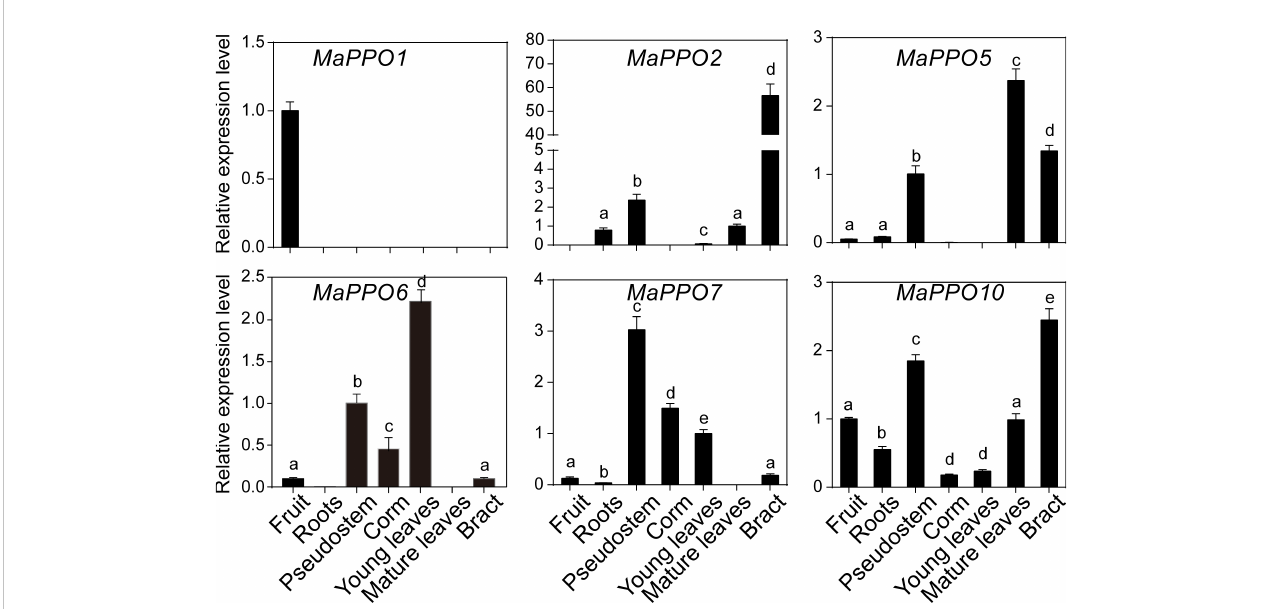
FIGURE 3 Expression pro fi les of MaPPOs in various tissues of Musa acuminate. The transcript level in one tissue was arbitrarily set to 1. Error bars represent the standard deviations of the mean value from three biological and three technical replicates. Different letters indicate signi fi cant differences (P < 0.05) examined by one-way analysis of variance